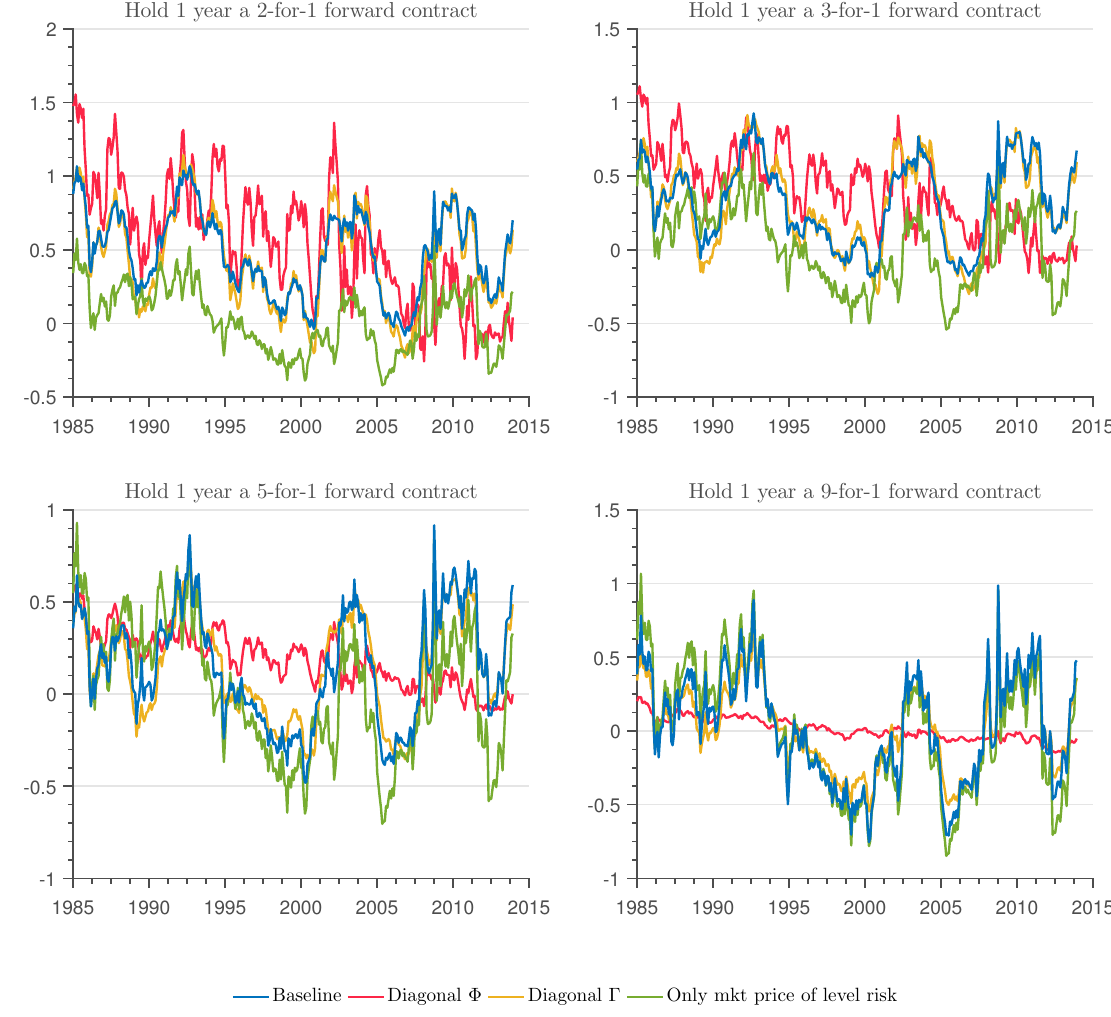
Figure 9. One-year holding forward risk